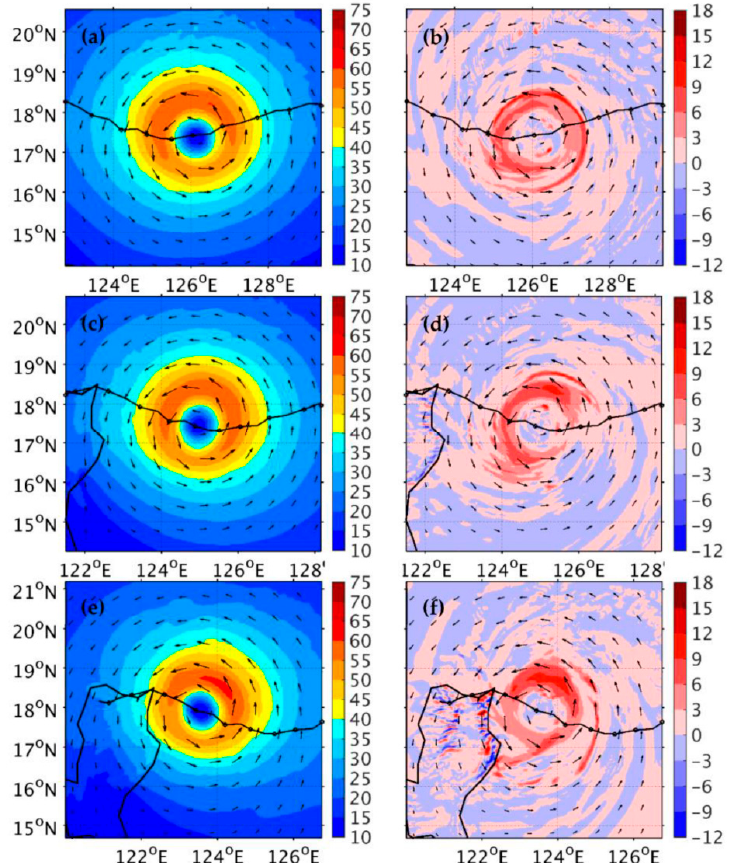
Figure 10. The simulated horizontal wind speed (shaded colors in m s − 1 ) averaged in 1–8 km height for YT-CTL at ( a ) 72 h, ( c ) 84 h, and ( e ) 96 h. ( b ), ( d ), and ( f ) are the same as in ( a ), ( c ), and ( e ), respectively, but for vertical velocity (shaded colors in 10 − 1 m s − 1 ). The black line shows the simulated track with solid cycles at an interval of 6 h.